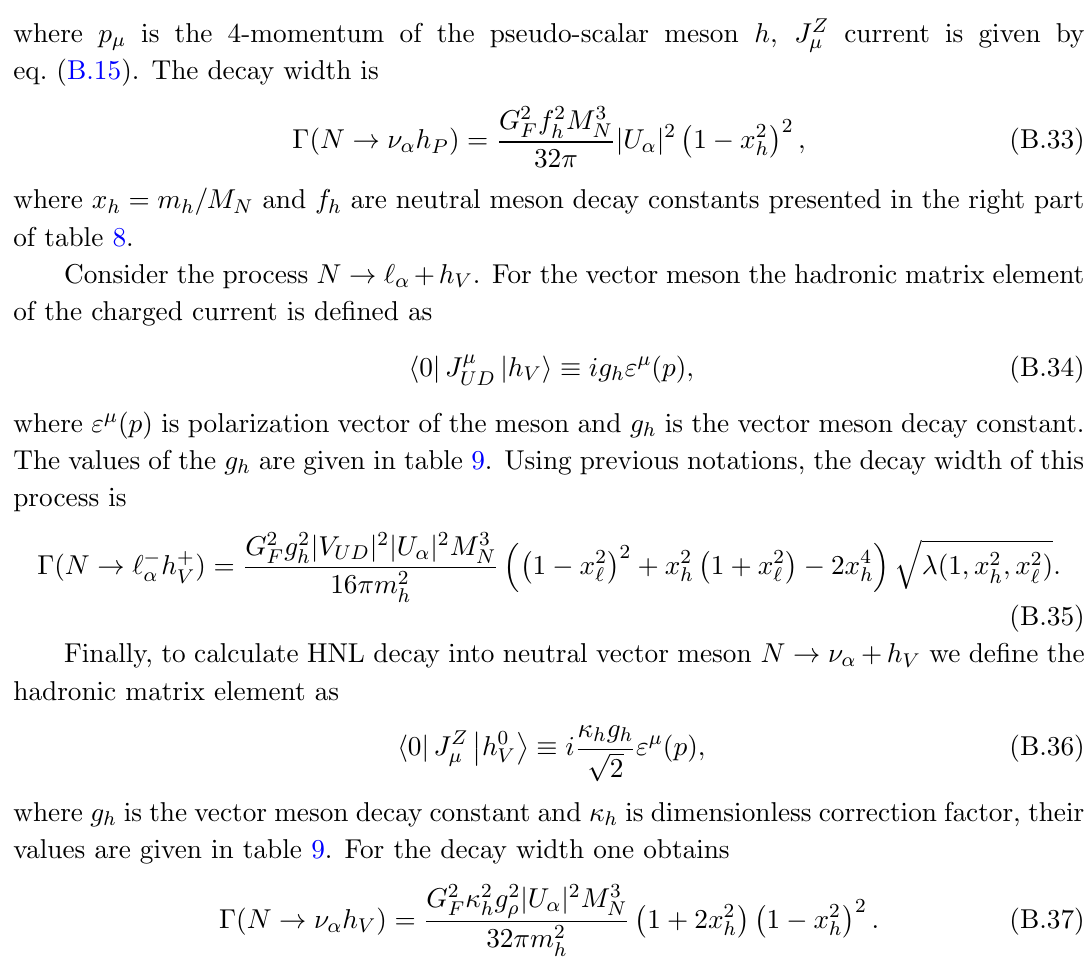
Figure 19 . Pion form factor squared, dominance model (blue line). Right: zoom to the energies around p s where p (cid:22) is the 4-momentum of the pseudo-scalar meson h , J Z